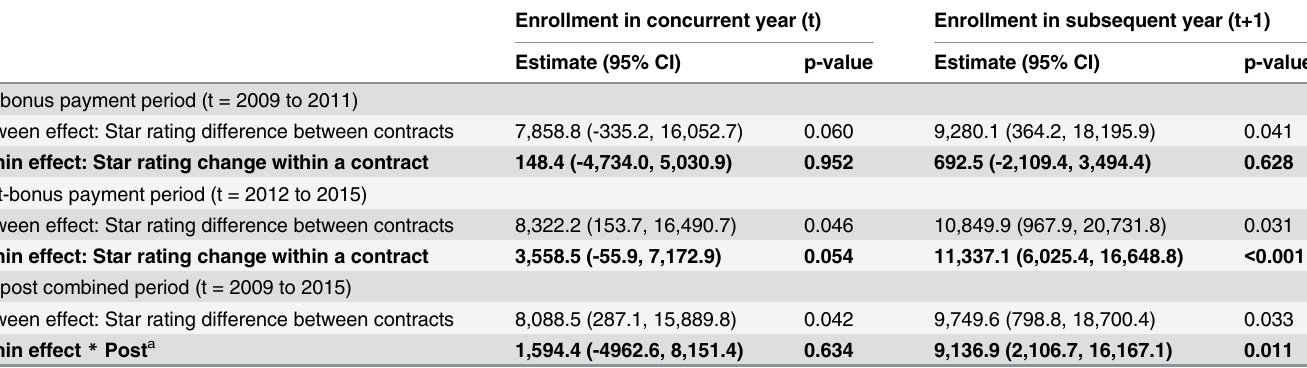
Table 2. Association of Star Rating and MAPD Contract Enrollment Before and After 2012 (Panel Data Hybrid Model) a